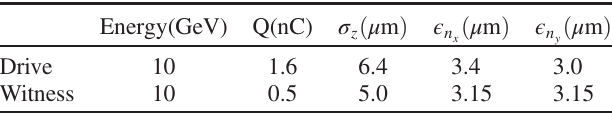
TABLE I. Possible beam parameters for two-bunch PWFA experiment at FACET II.